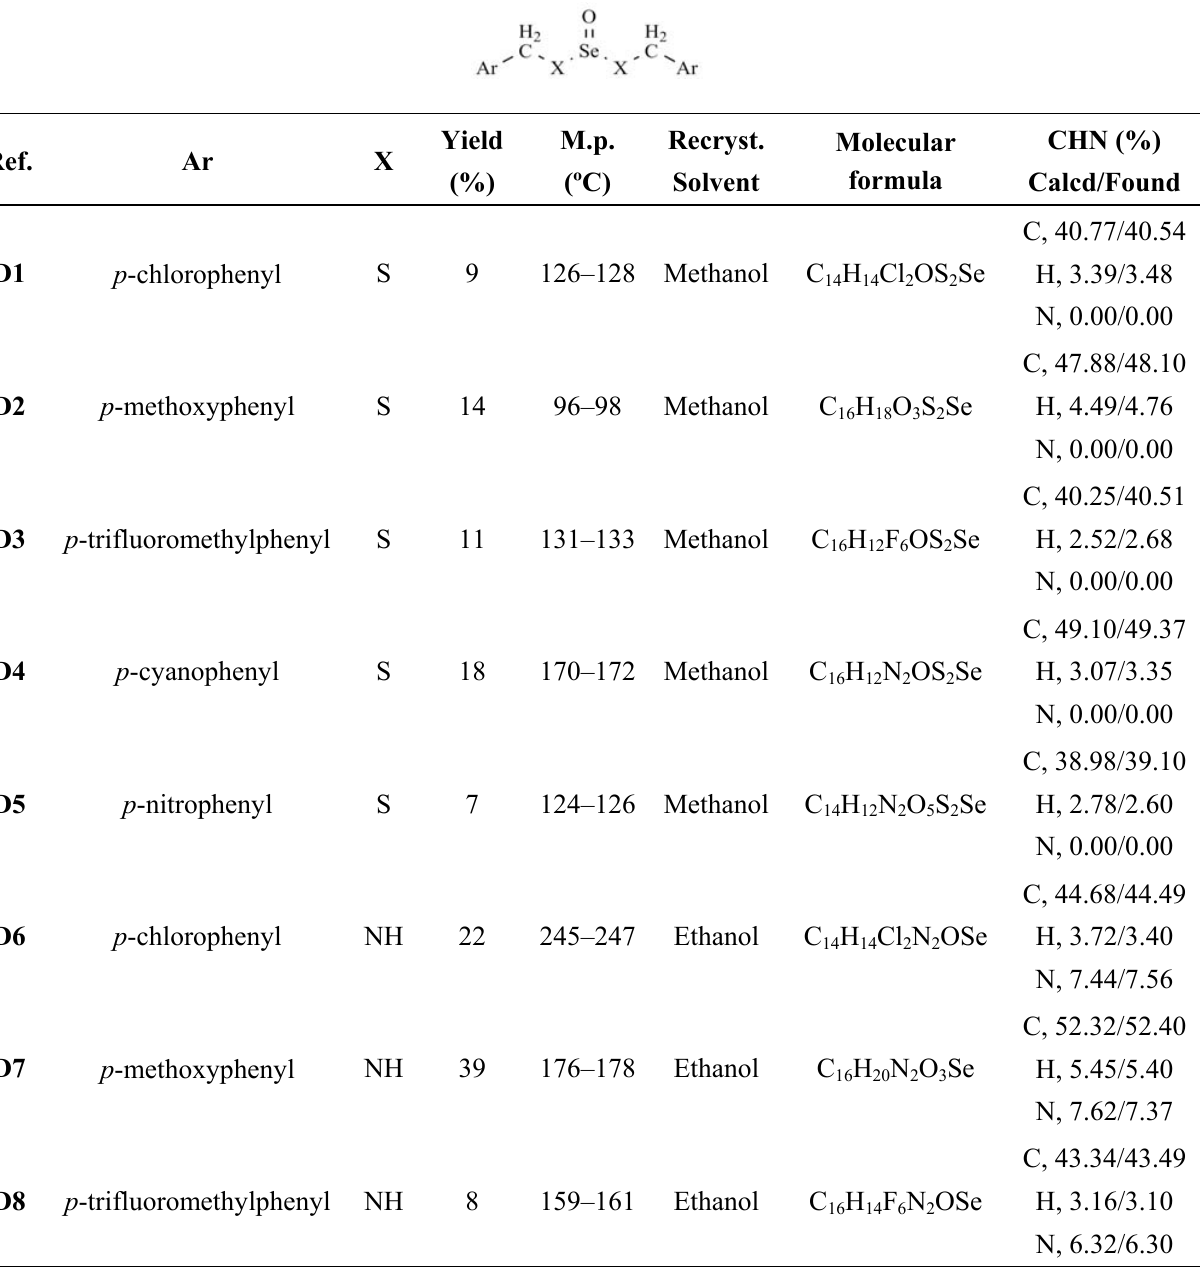
Table 1. Physical constants for compounds D1-D8